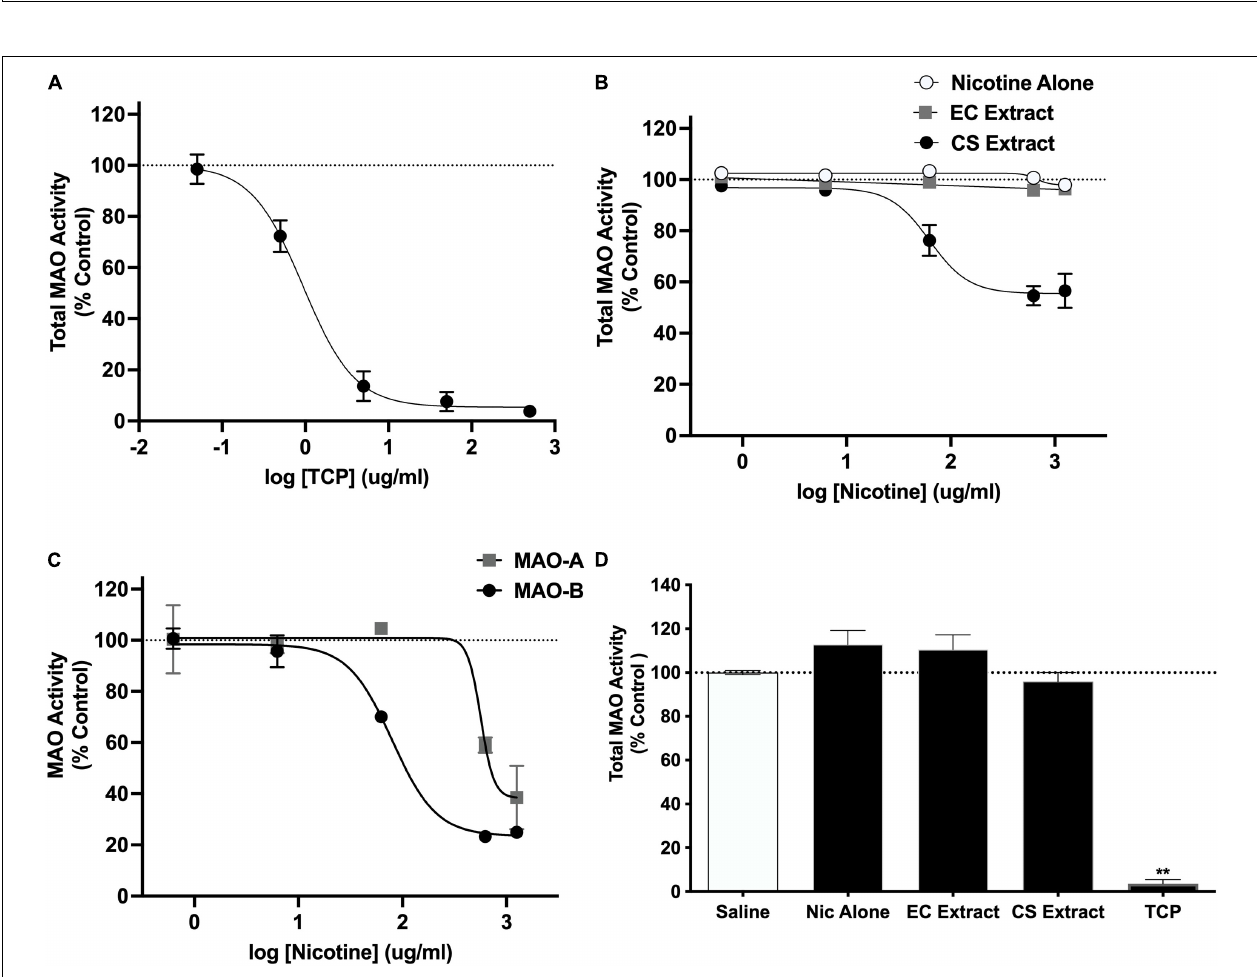
Frontiers in Neuroscience |